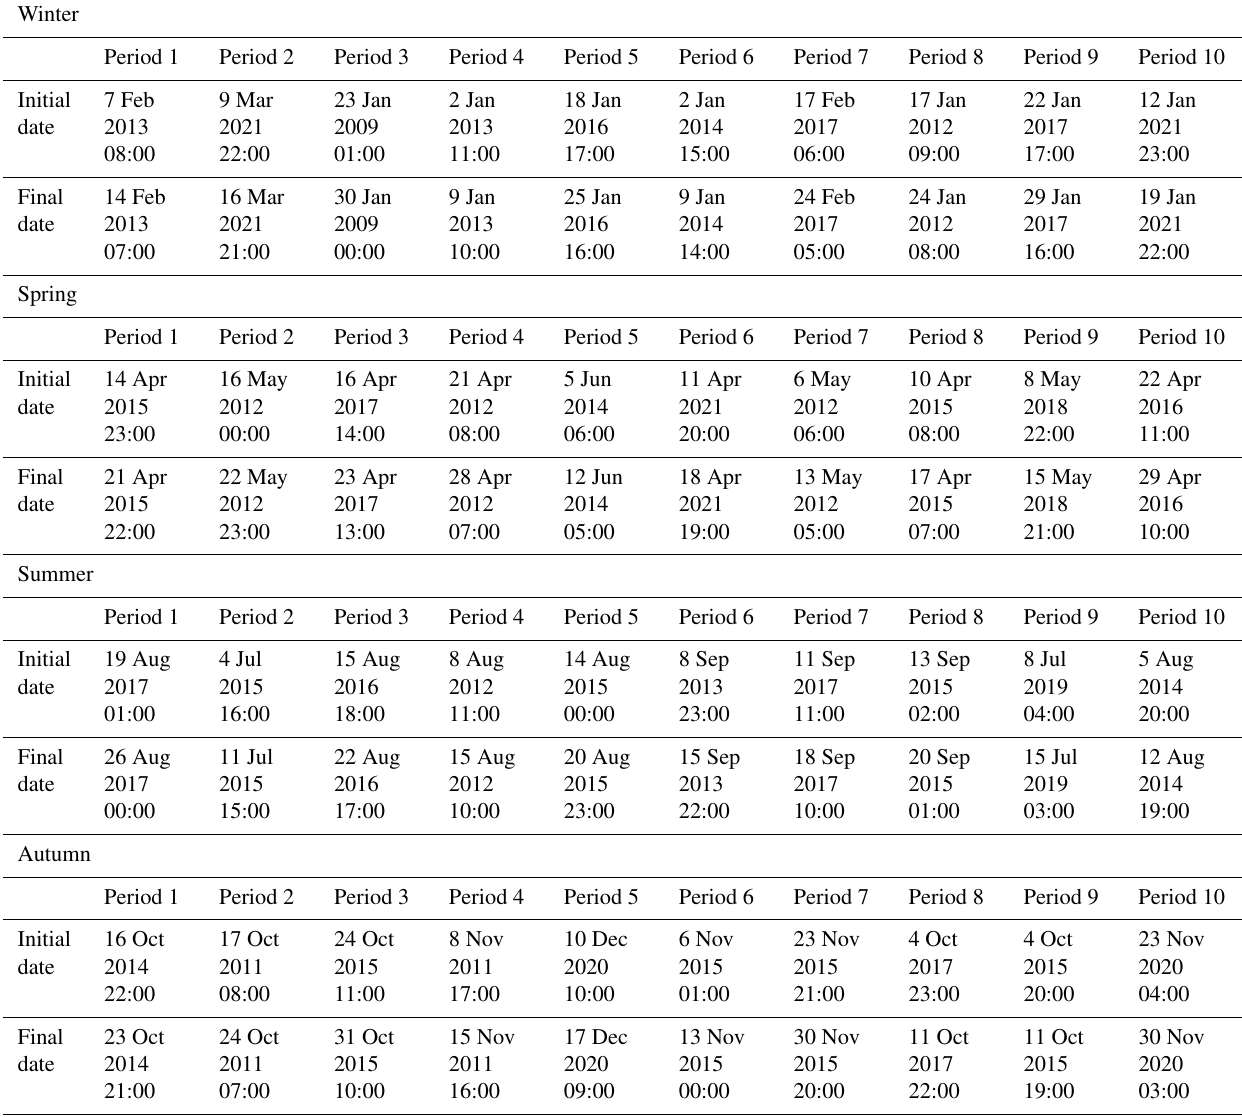
Table C1. Periods selected between 2009 and 2021 based on the availability surface current datasets provided by the HF radar.